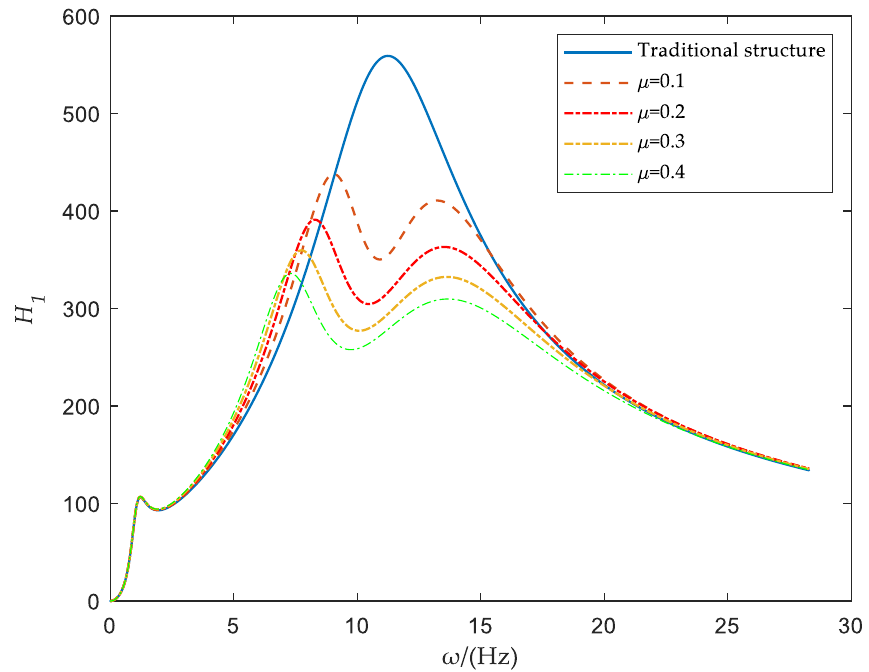
Figure 2. Frequency response function curves of SMA.